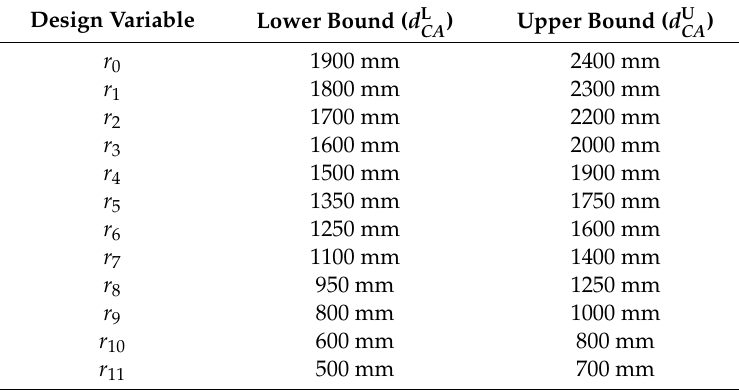
Table 5. Bounds for design variables of